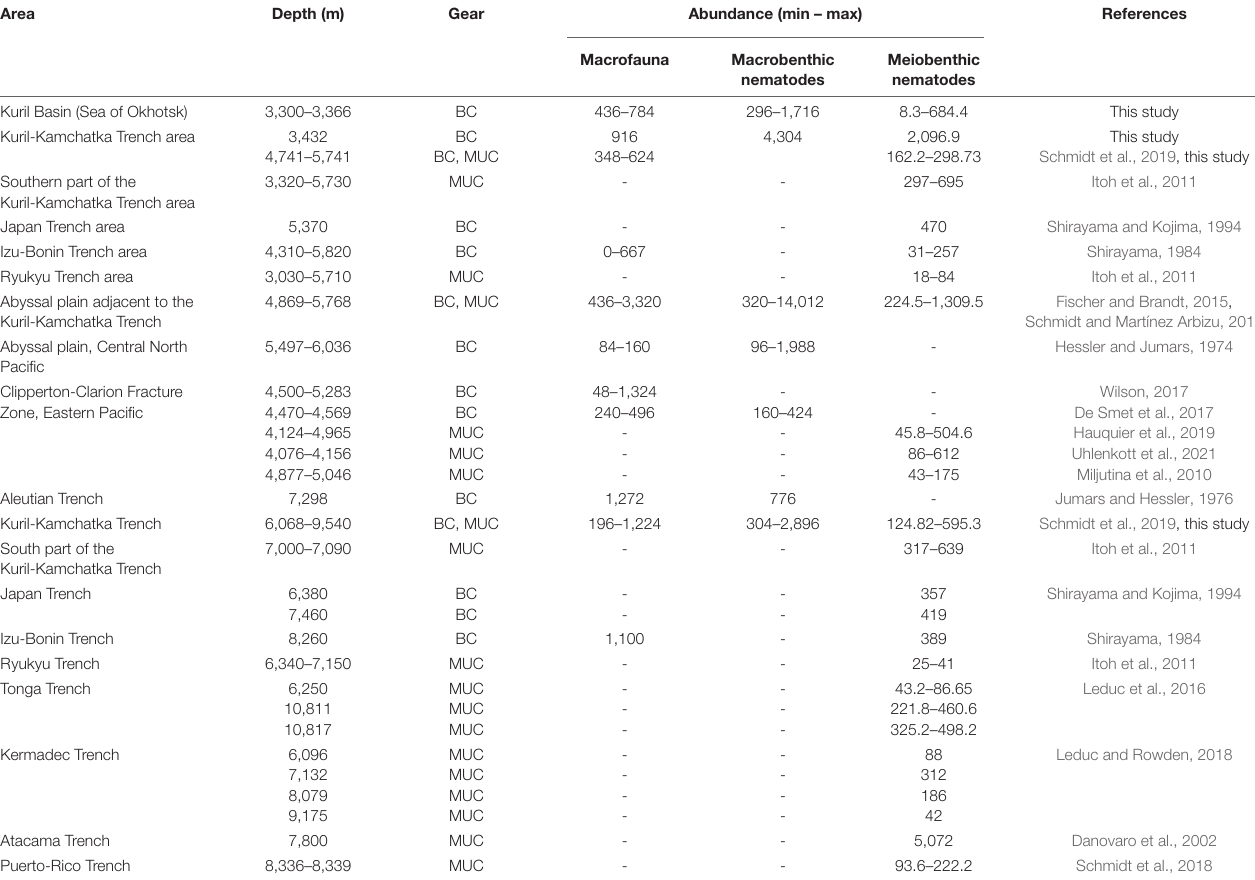
TABLE 6 | Abundance of macrofauna (ind. m − 2 ), macro- (ind. m − 2 ) and meiobenthic (ind. 10 cm − 2 ) nematodes from different abyssal areas (depths more than 3,000 m) of the North Pacific and trenches. Area Depth